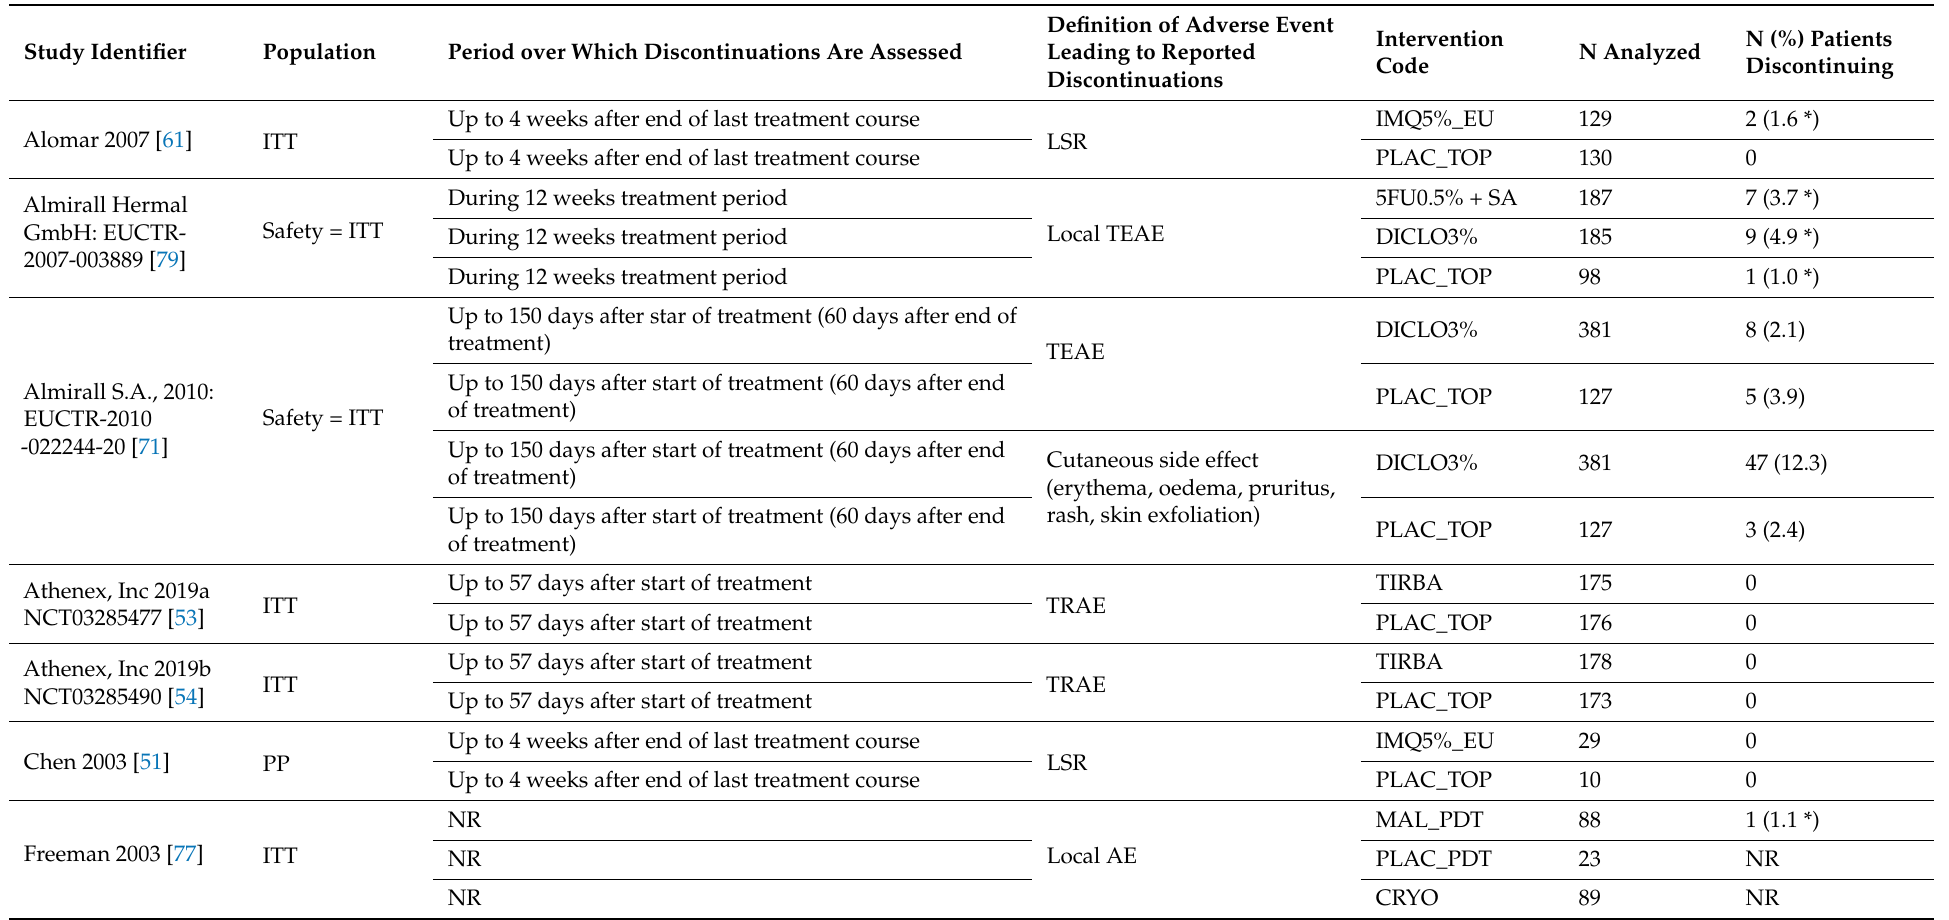
Table 2. Discontinuations due to TRAEs, TEAEs, local AEs, or